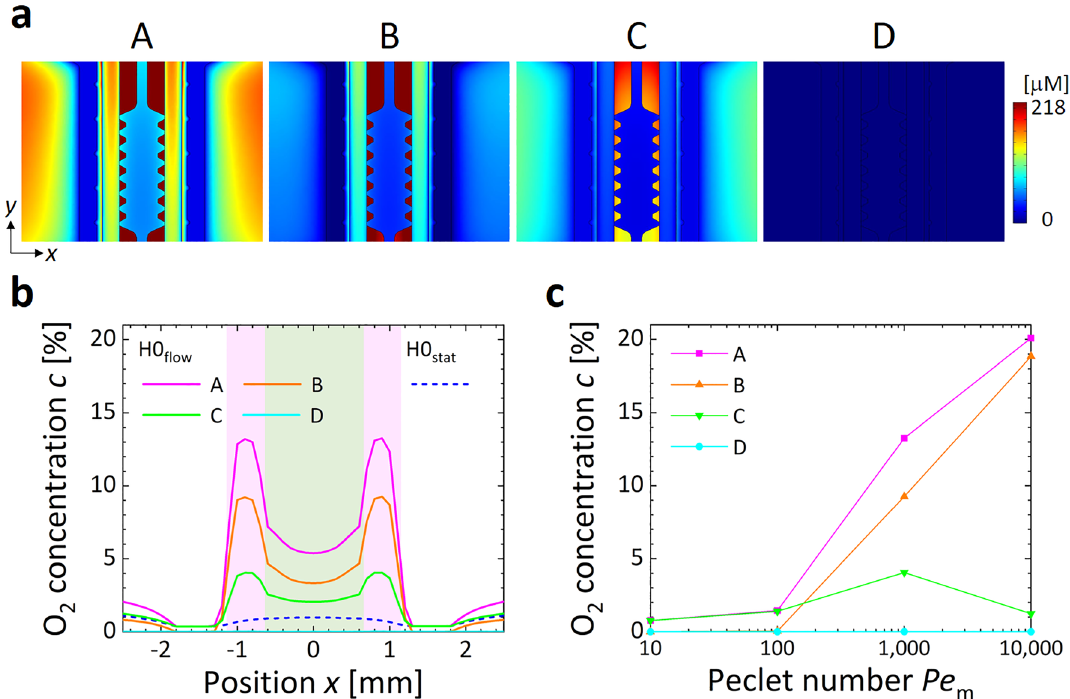
Figure 2. Computational results of steady oxygen concentration in the microfluidic device. ( a ) Oxygen distributions on the horizontal cross section ( z = 0 mm) and ( b ) profiles of oxygen concentration c across the media and gel channels ( y = 0 mm) under the hypoxic condition H0 flow at Pe m = 1,000, generated by different oxygen control methods A–D (see Table 3), and for the static condition H0 stat at Pe m = 0 by the method A. For the method A, a gas mixture without oxygen ( c g = 0%) was supplied only to both gas channels. For the methods B, C, and D, the oxygen concentrations either in the stage incubator c i , in the supplied medium c m , or both, was additionally controlled at 0% O 2 . The origin was set at the center of the gel channel, and the x -direction was defined as the horizontal direction normal to the gel channel. Regions shaded with pink and green indicate sections of the media and gel channels, respectively. ( c ) Variations in oxygen concentration c at the center of the media channel (| x |= 0.9 mm, y = 0 mm, z = 0 mm) with Péclet numbers Pe m for the medium